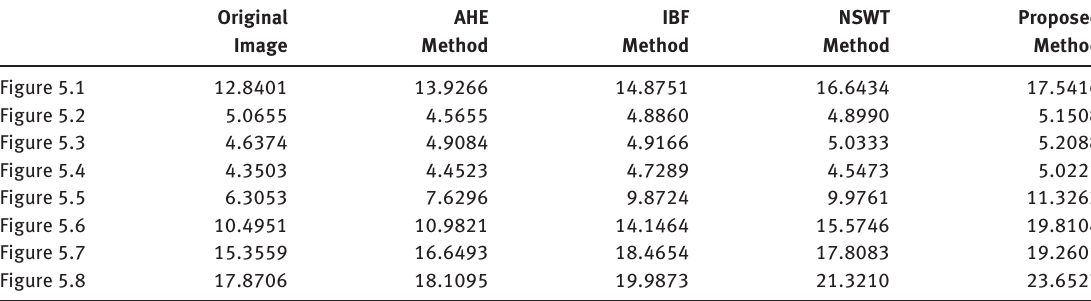
Figure 5.2 Figure 5.3 Figure 5.4 Figure 5.5 Figure 5.6 Figure 5.7 Figure 5.8